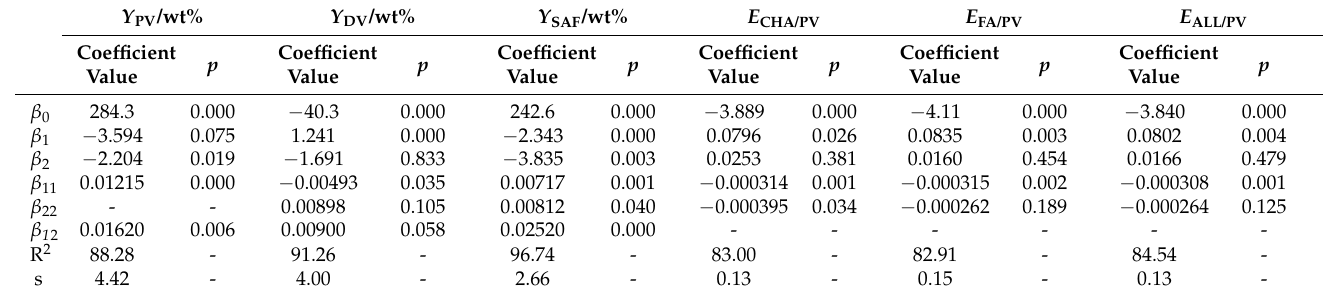
Table 4. Fitting coefficients of Equation (8) for PV, Y PV , DV, Y DV , and overall, Y SAF , yields, chloro- genic and ferulic acid enrichment ratio in PV ( E CHA/PV , E FA/PV respectively) total enrichment ratio ( E ALL/PV ) as well as the significance of each term, p , the regression coefficients, R 2 , and standard deviation,